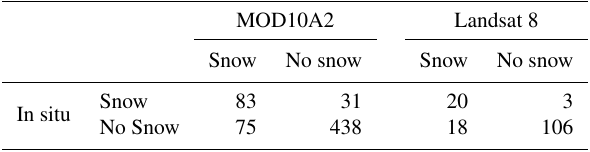
Table 4. Confusion matrices for comparison of Landsat 8 snow maps and MOD10A2 snow maps with in situ snow observations.